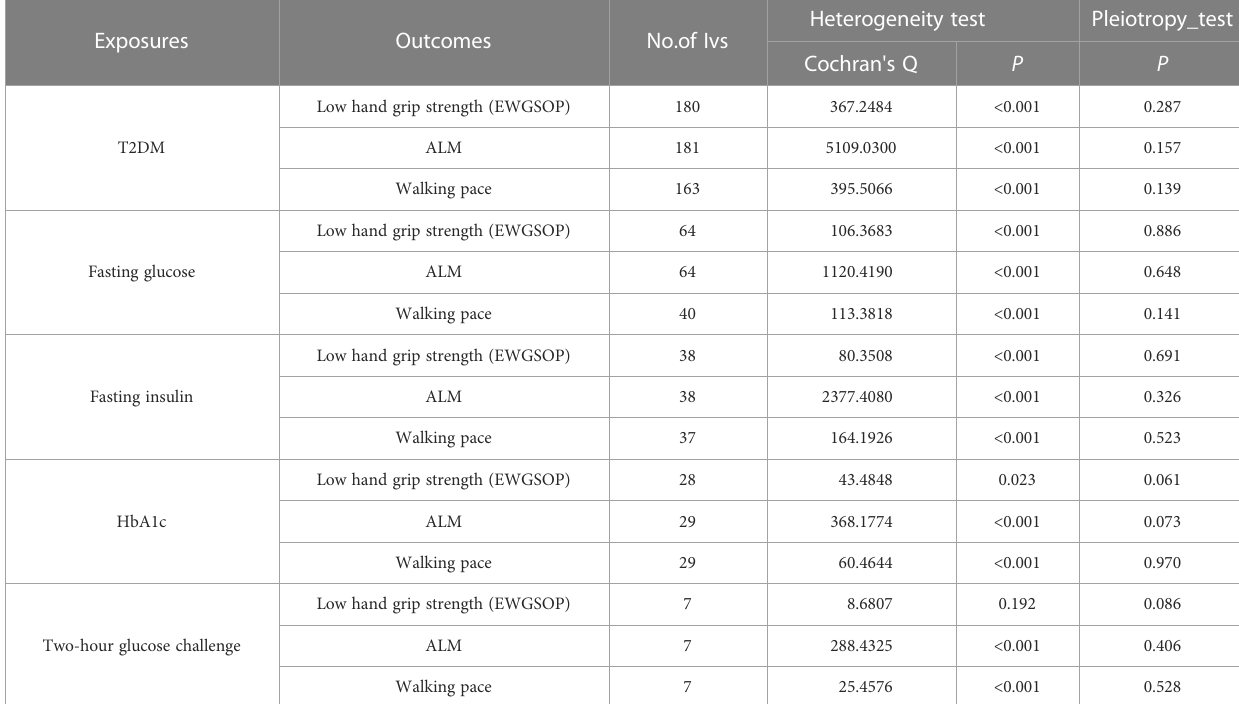
TABLE 5 Association T2DM and glycaemic traits with sarcopenia-related traits using heterogeneity test and pleiotropy test.